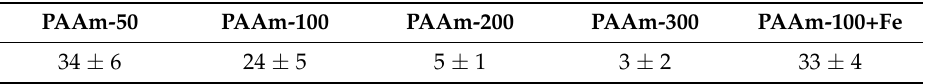
Table 3. Young modulus (in kPa) obtained in the tested samples. The mean values ( n = 4) and standard deviations are shown. The concentration of iron oxide MNPs in ferrogel was 0.34